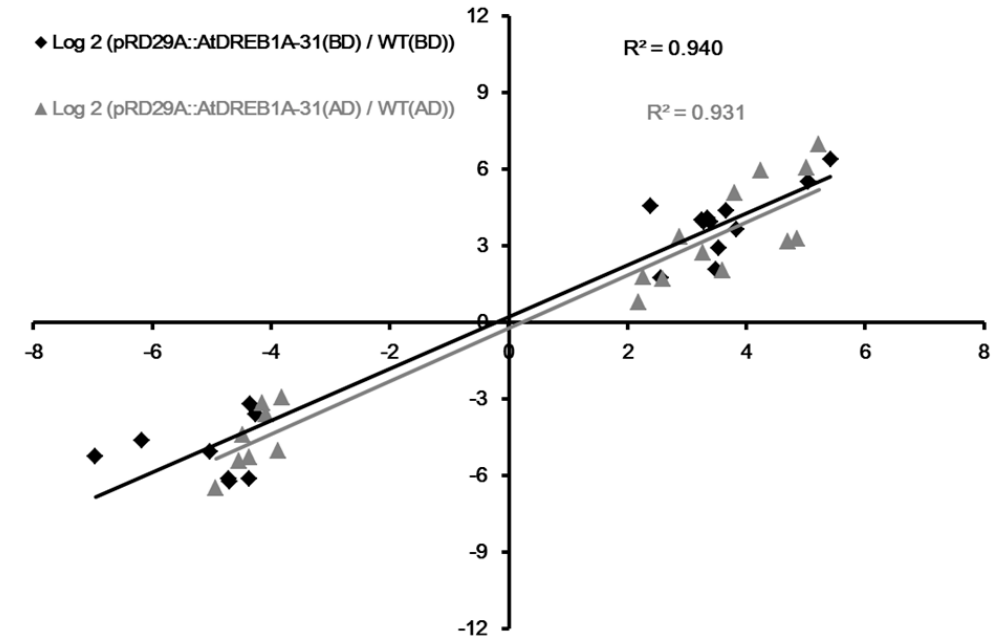
Figure 9. Correlations in changes in gene expression between fold-change determined from RNA-seq data (X-axis) and data obtained using qRT-PCR (Y-axis). WT, wild-type; pRD29A::AtDREB1A-31, pRD29A::AtDREB1A transgenic line 31. BD, before drought; AD, after six days of drought.